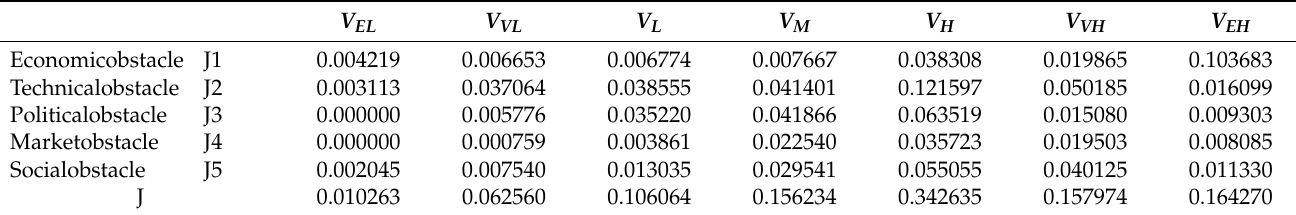
Table 6. The membership degree of five categories of